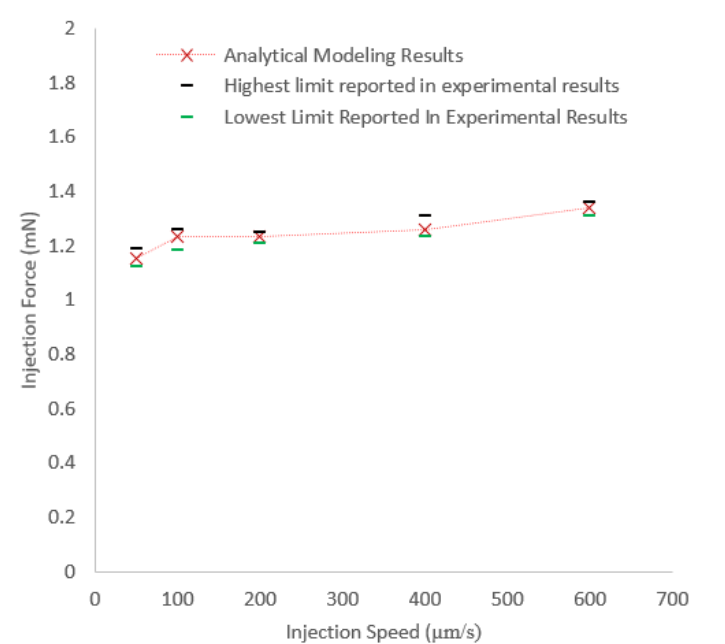
Figure 11. Comparison between experimental and analytical